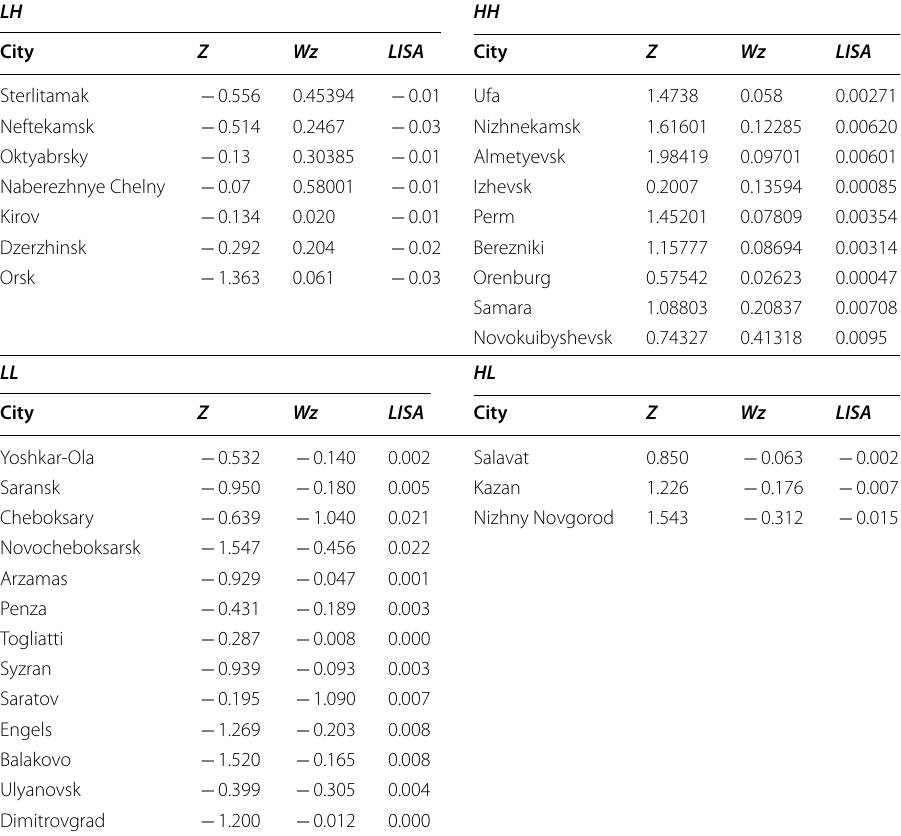
Table 4 Grouping of cities of the Volga Federal District of Russia by the Moran’s index (average monthly salary) in 2017 (Russian regions. Main social and economic parameters of cities. 2018 // Federal Service of State Statistics [Electronic resource] URL:http:// www. gks. ru/ free_ doc/ doc_ 2018/ region/ reg- gor18. pdf (date of application